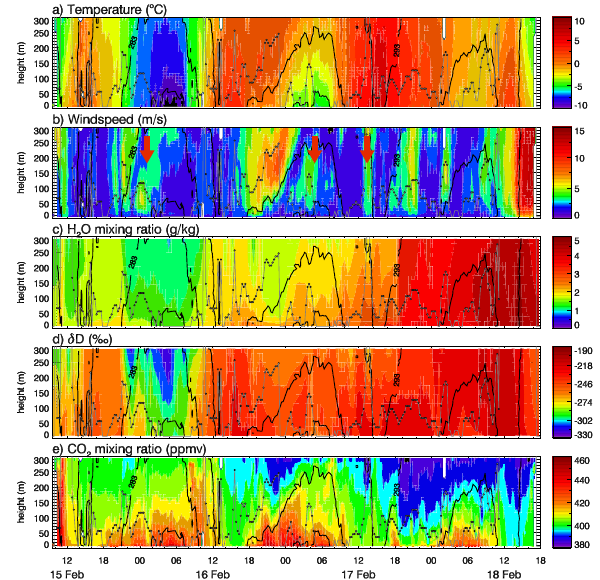
Fig. 3. Time height sections of (a) temperature ( ◦ C), (b) wind speed (ms − 1 ), (c) water vapor mixing ratio (i.e., q , gkg − 1 ), (d) δ D (‰), and (e) CO 2 volume mixing ratio (ppmv). Contours show potential temperature (K). Grey dots show where the Richardson number is the critical value, and the grey line estimates the depth of the con- vective layer. The time axis is in hours local Mountain Standard Time, and spans from 09:00 a.m. 15 February to 06:00 p.m. on 18 February. Arrows indicate examples of intermittent turbulent burst events.